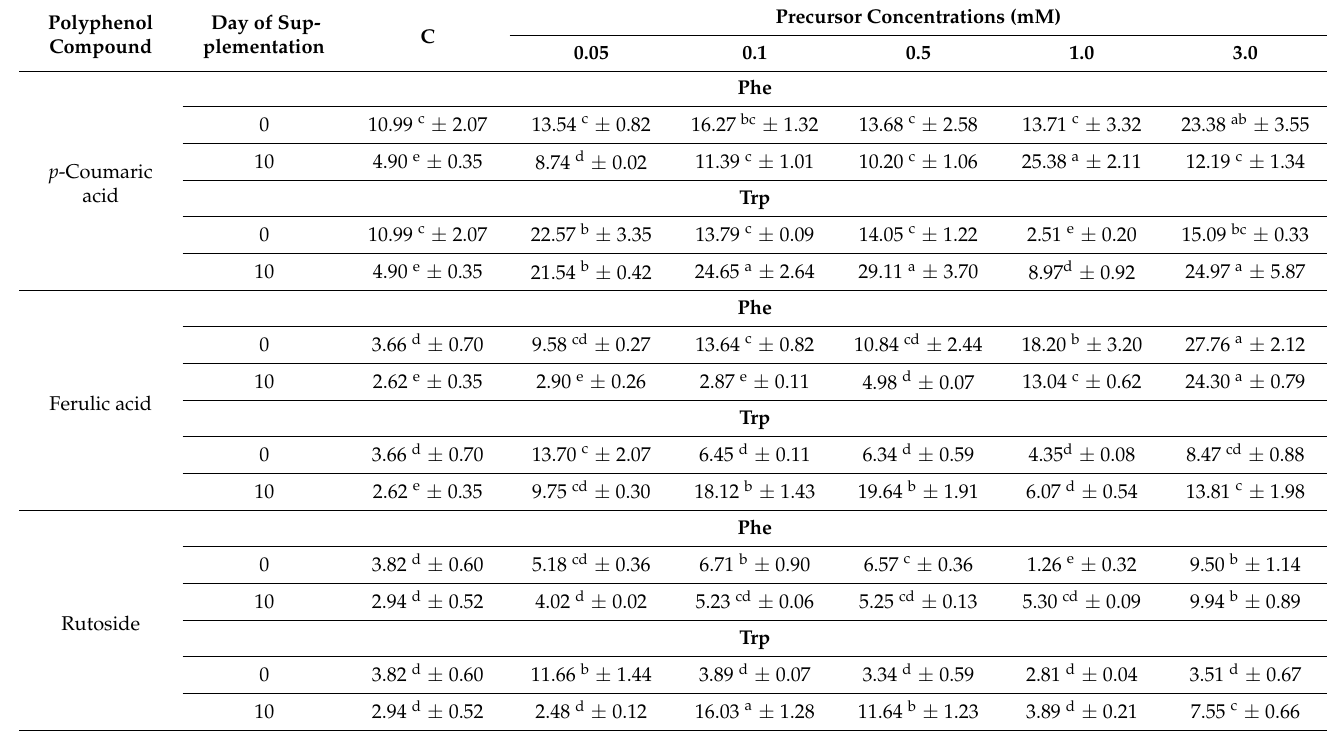
Table 6. Amounts of individual polyphenol compounds (mg/100 g DW ± SD) in extracts of bioreactor-grown N. officinale microshoot cultures after precursor